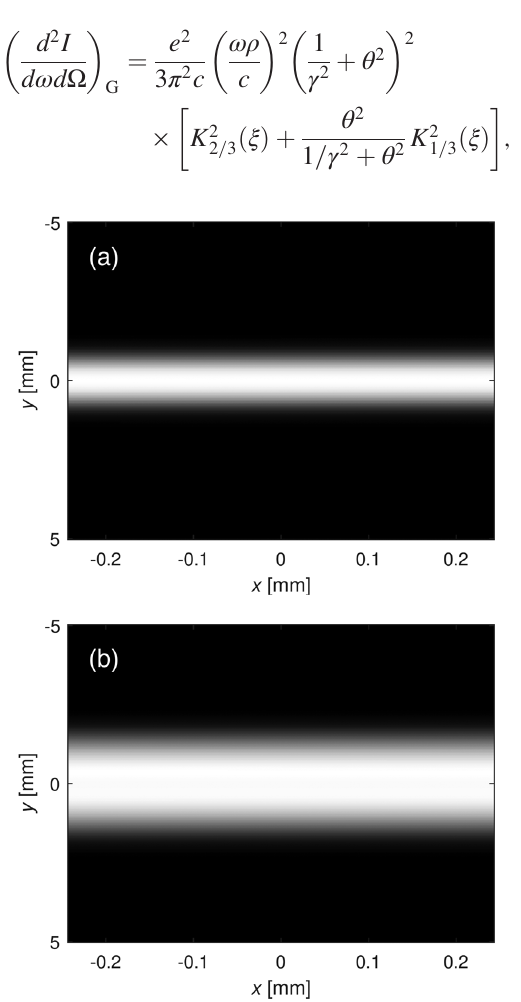
FIG. 3. Simulated intensity of SR (at 2.39 keV, critical energy) from a filament electron beam for (a) no noise and (b) a harmonic noise with amplitude a ¼ 0 . 2 mrad.